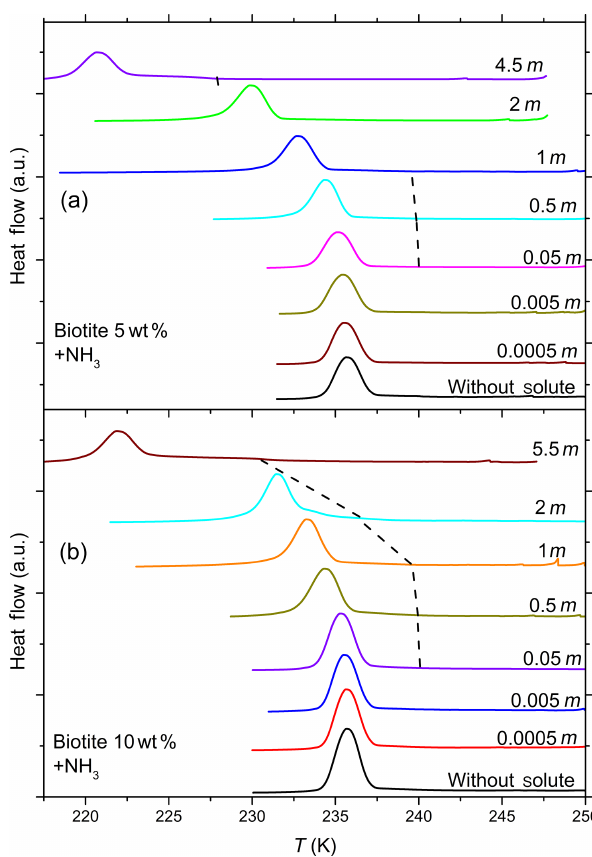
Figure 8. DSC thermograms of 5wt% (a) and 10wt% (b) biotite particles suspended in ammonia solution droplets (0–5.5molal; a w equal to 1–0.912). All curves are normalized such that the areas un- der the heterogeneous and homogeneous freezing curves sum up to the same value. In contrast to muscovite, biotite becomes IN active only at very high concentrations of ammonia. In addition, the in- tensity of the heterogeneous freezing signal (hence F het ) is low, but becomes more prominent in 10wt% suspensions (see Table